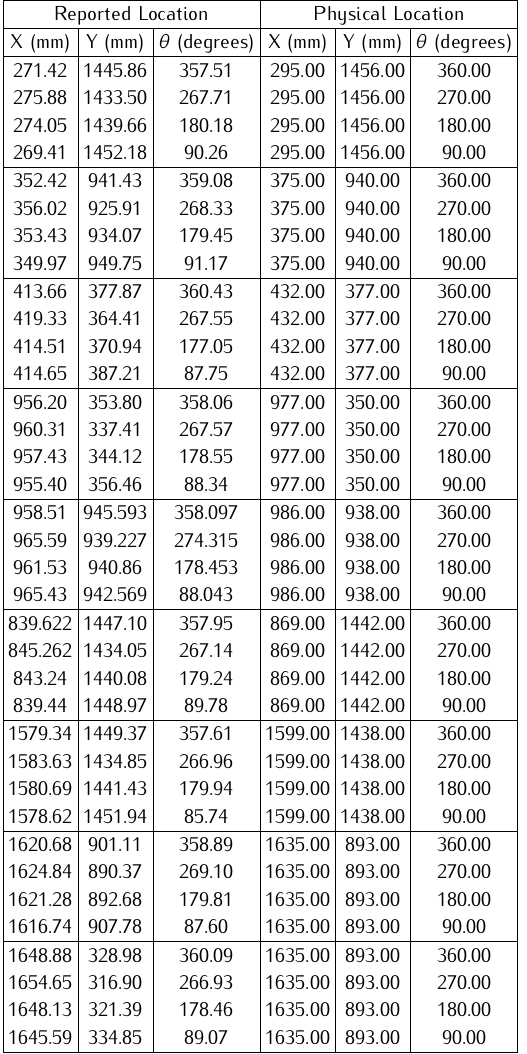
position error figures for this set of tests. For this diagonal path test, cumulative error figures are as follows: 1-Norm Error is 172.677 mm, 2-Norm Error is 55.6885 mm and ∞ - Norm Error is 21.4502 mm. Heading or orientation